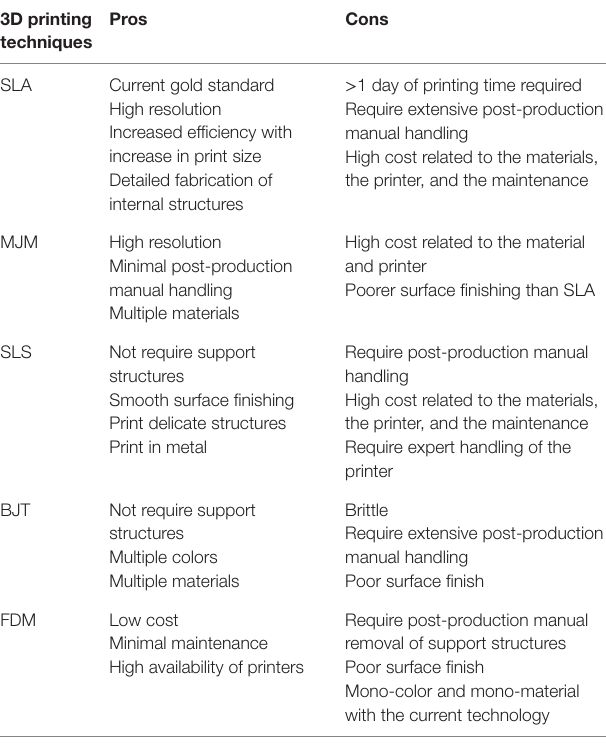
TABLe 1 | A summary of the most commonly used 3D printing techniques in medical